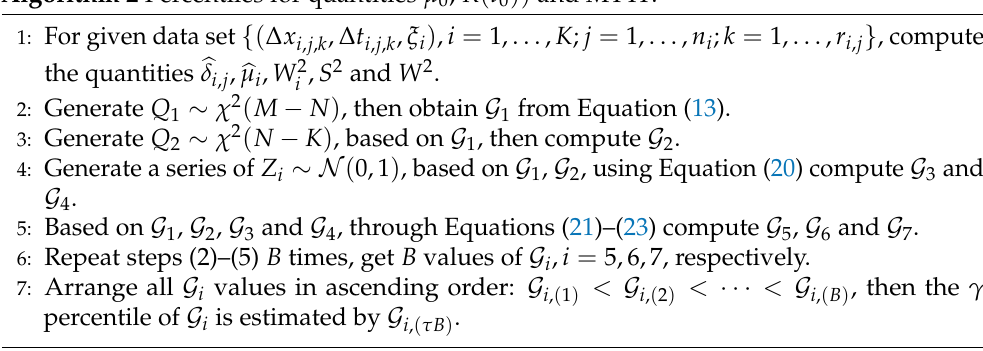
Algorithm 2 Percentiles for quantities µ 0 , R ( t 0 )) and